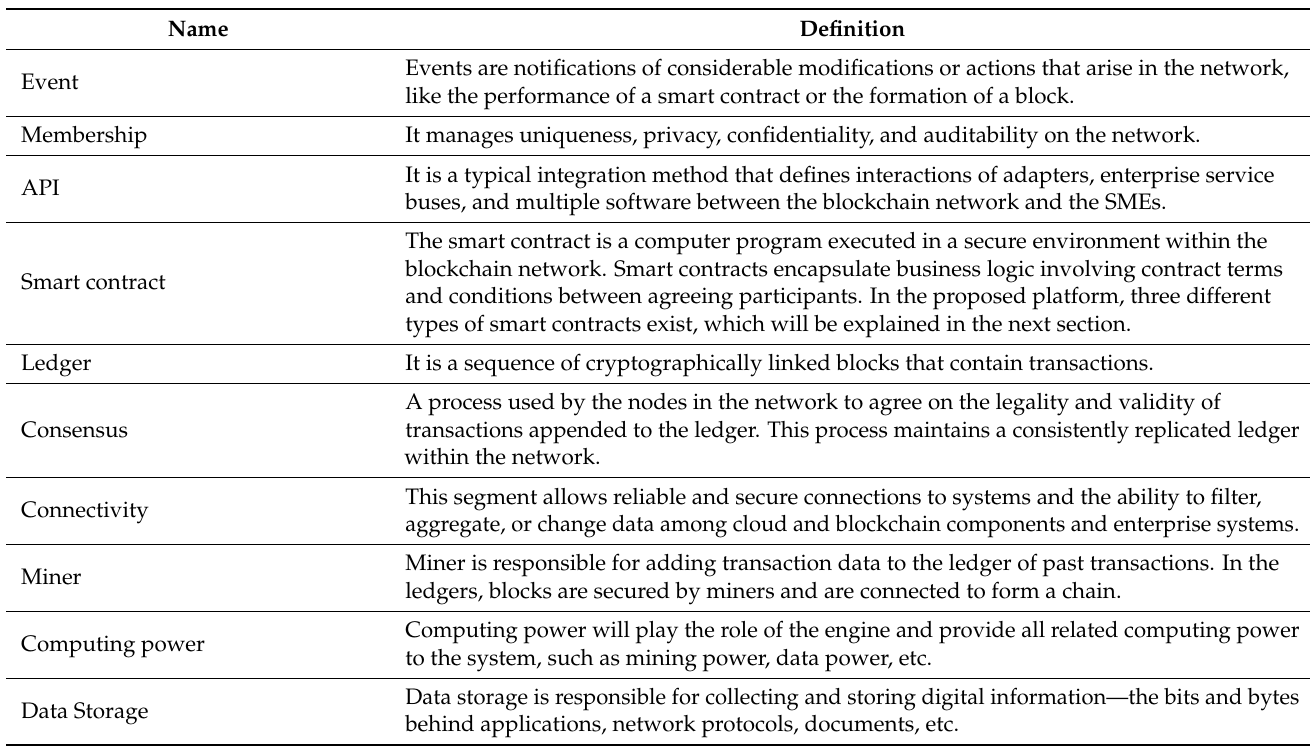
Table 1. Explanation of each DC components .